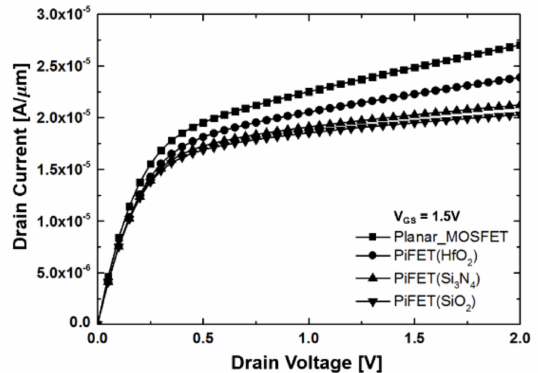
Figure 8. I DS -V DS characteristics for the planar MOSFET; the PiFET with a silicon film thickness of 15 nm; and the buried insulators of the SiO 2 , Si 3 N 4 , and HfO 2 material.